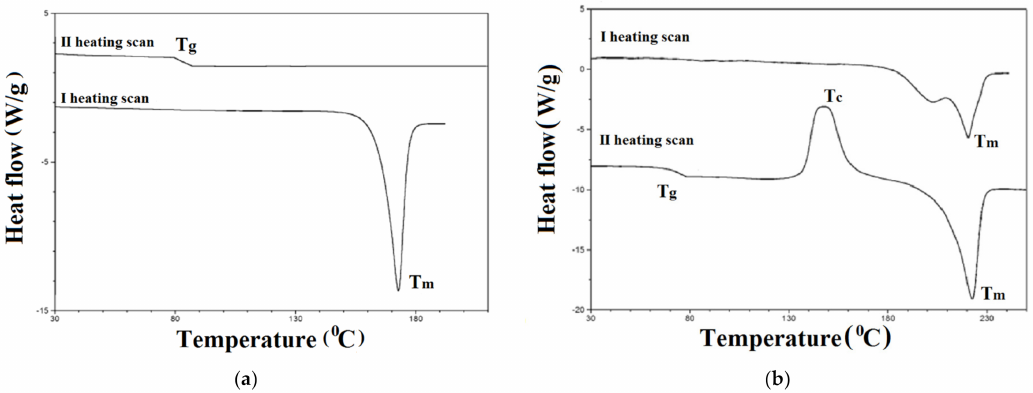
Figure 2. The DSC thermograms of ( a ) 1a and ( b ) 1c registered in I and II heating